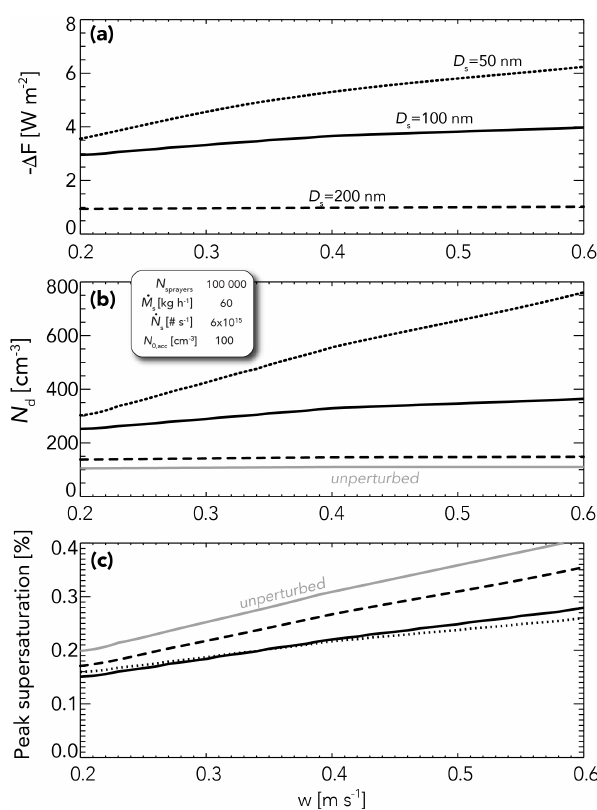
Figure 9. Impact of assumed updraft speed on (a) global mean ra- diative forcing − (cid:49)F . (b) Cloud droplet concentration N d . (c) Peak supersaturation during activation for a fixed salt mass spray rate (based on scenario 2; see the legend). Results for injected particle sizes ( D s = 50, 100, and 200nm) are shown. Panels (b) and (c) also show the values for the unperturbed